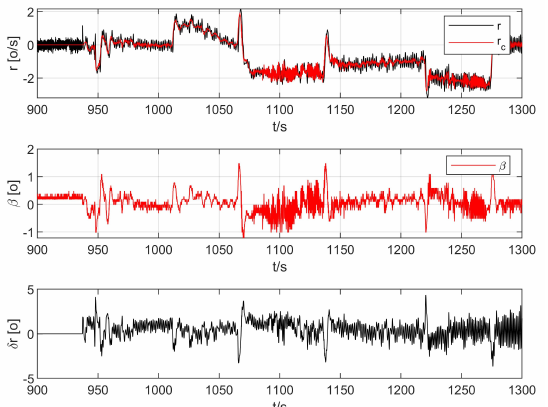
Figure 31. Flight test data. Command and response value of the yaw